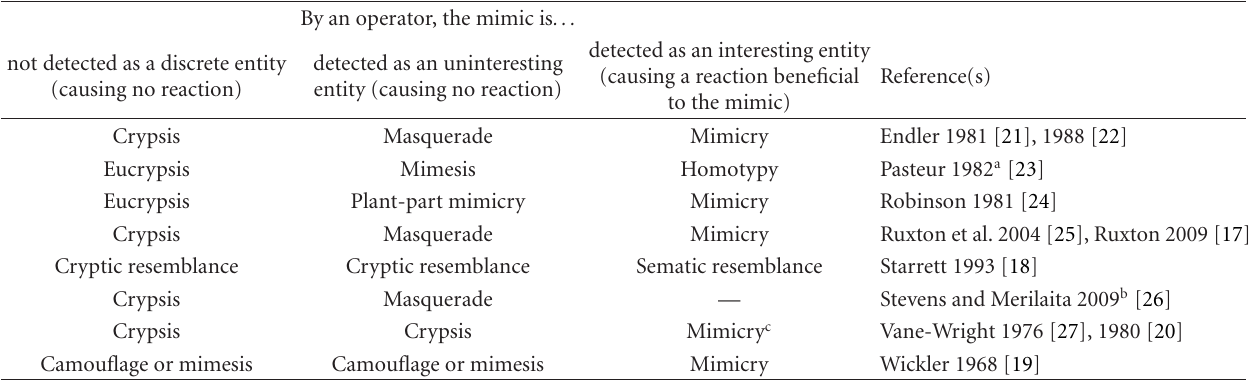
Table 1: Summarized table of adaptive resemblance terms in general biology as used in important reviews. Systems can either be considered according to what a mimic pretends to be or according to what an operator perceives. We adopted the latter view. By an operator, the mimic is